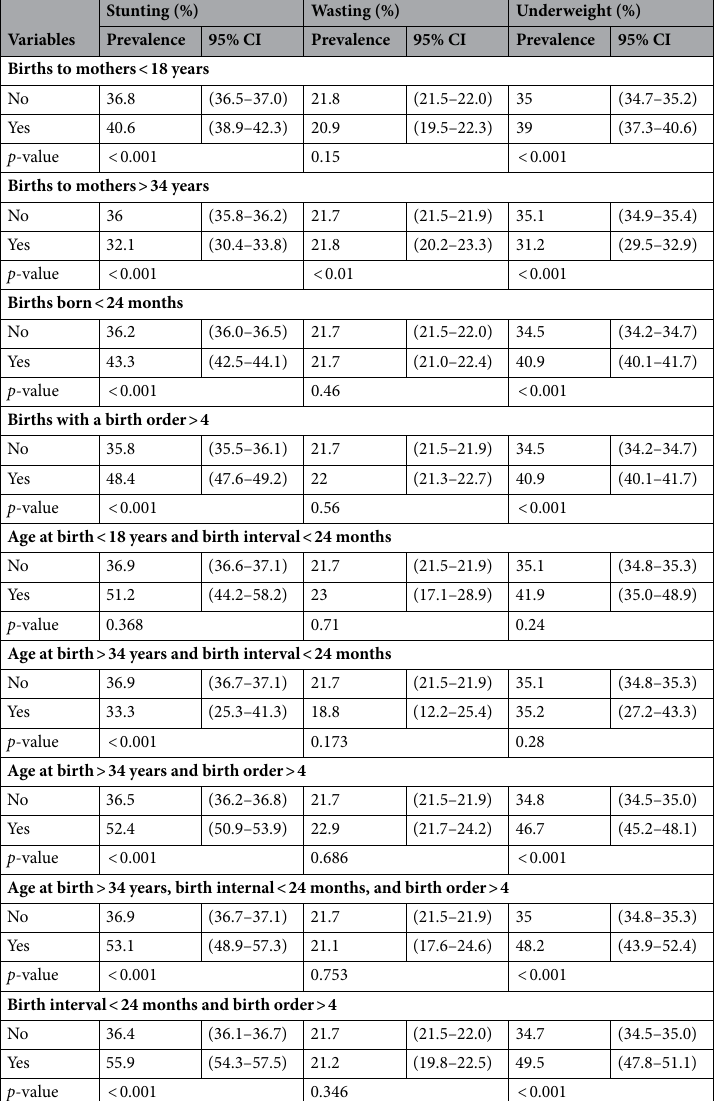
Table 5. Prevalence of children nutrition outcomes by maternal high risk births conditions among currently married women children aged 0–59 months, India NFHS-4. p values present the level of significance of Pearson’s chi-square